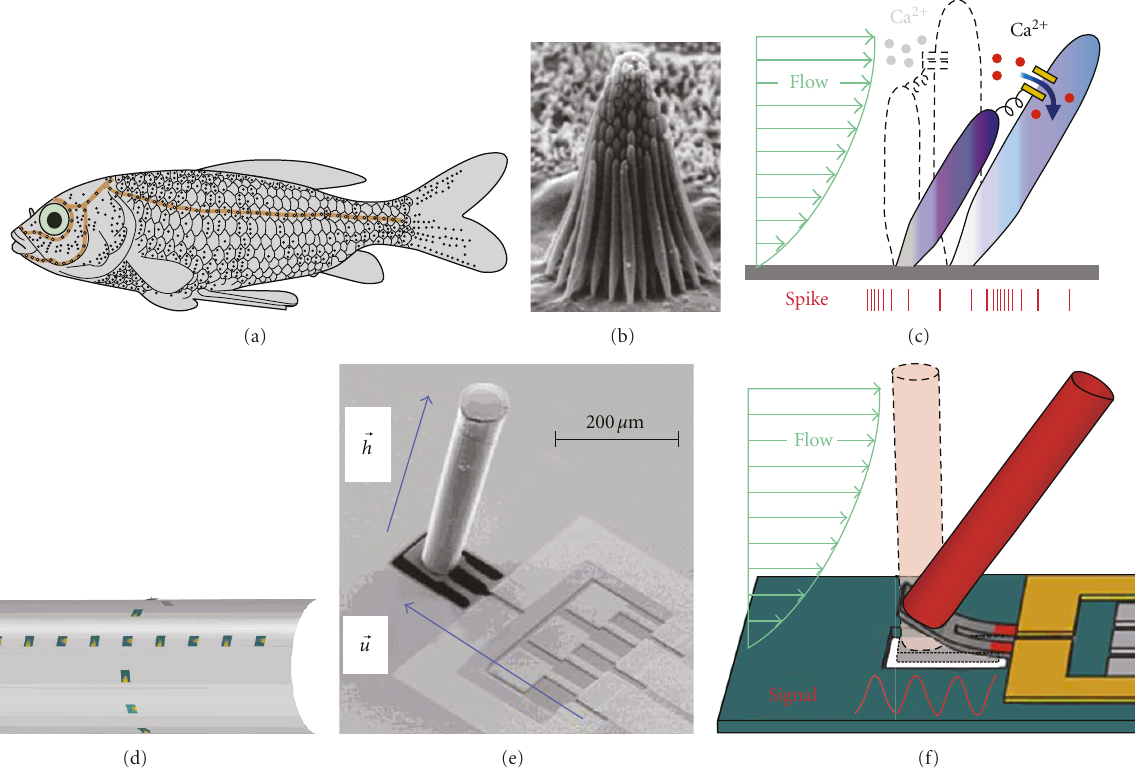
Figure 1: (a) Distribution of neuromasts, a cluster of hair-cell organs indicated by black dots, on a Carassius auratus goldfish’s body (modified from Schmitz et al. [14]). (b) A close-up image of a neuromast which is made of many hairs. (c) Illustration of a neuromast’s function to generate excitation spikes when hairs are bended. (d) Testing platform with 15 artificial hair-cell sensors. (e) A close-up image of a sensor. (f) Operation principle of the artificial hair-cell sensor. All (c)–(f) are modified from [11].